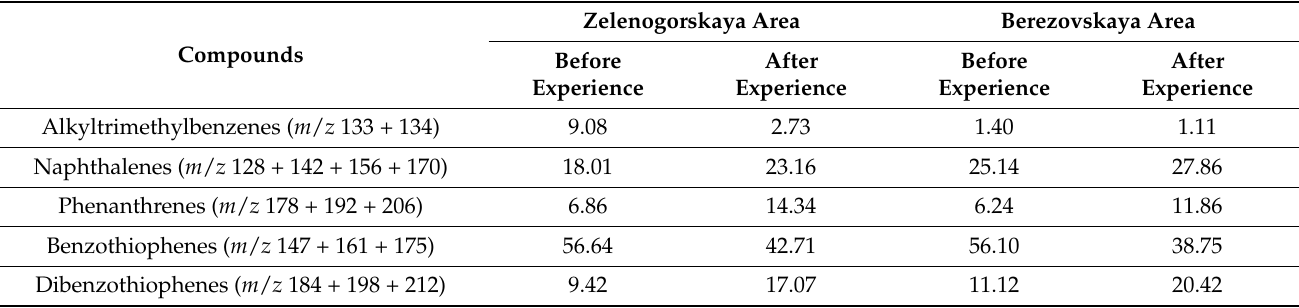
Table 5. Relative content (%) of different type of compounds in aromatic fractions of shale oil before and after the hydrothermal experiments.